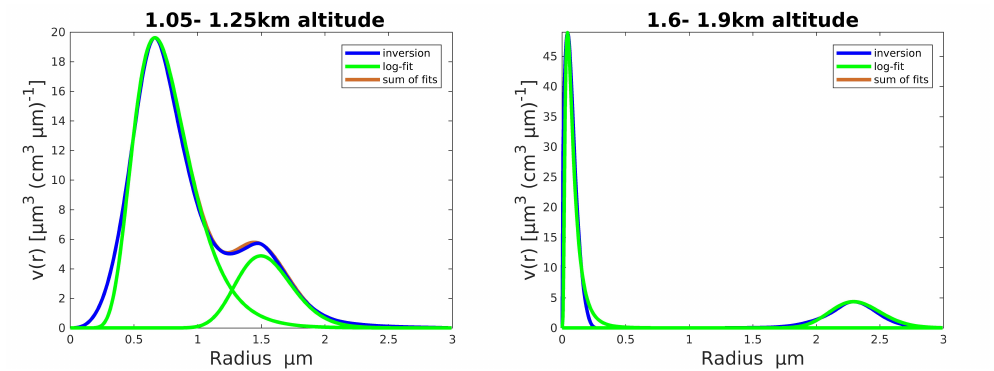
Figure 6. Volume distribution function of the particle radius r for 13 January for two different altitudes, one within the MBL and one above. Blue: result of the inversion; green: log-normal fits. If the sum of the fits (in red) cannot be seen, it is congruent with the inversion. All values are given in Table 3. The mode with the smaller radius r mod is referred to as the first mode